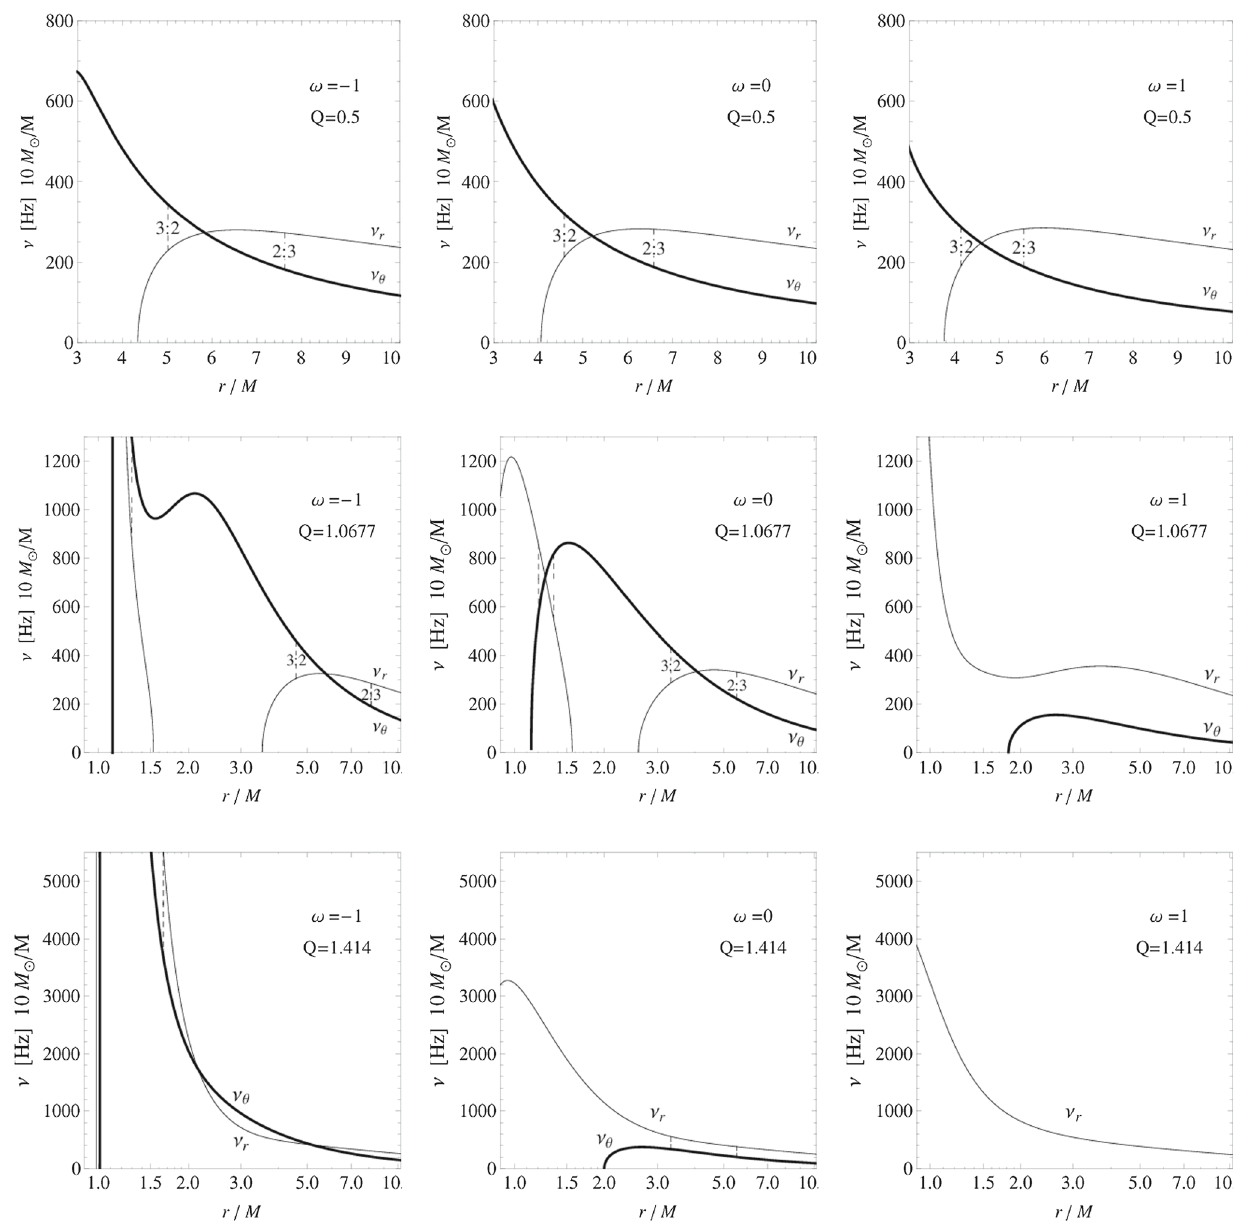
Fig. 9 Radial profiles of radial and vertical fundamental frequencies ν ν θ measured by distant observers, determined for harmonic string r , loop oscillations around stable equatorial equilibrium states. String